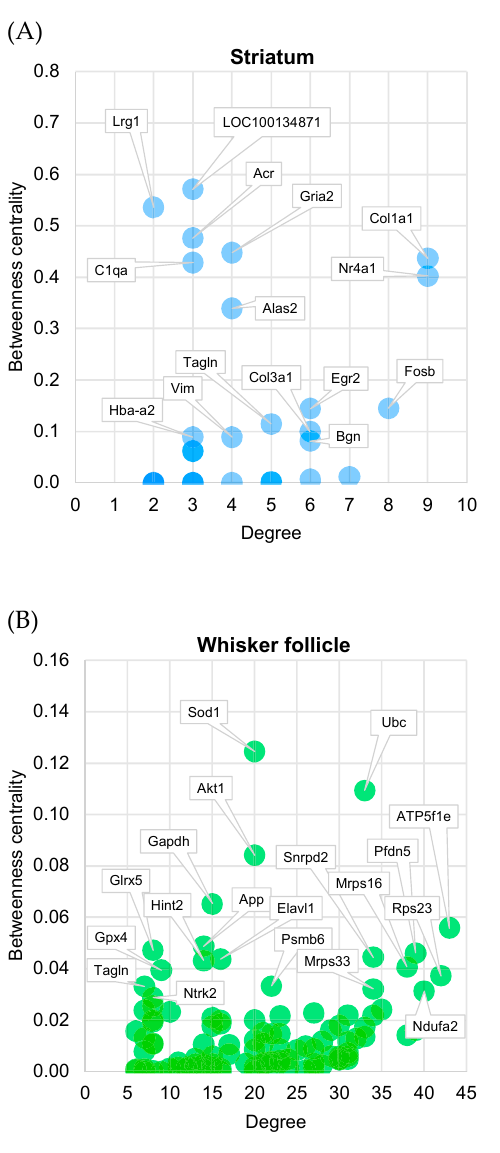
Figure 6. Centrality analysis and lists of the top 20 hub genes. ( A , B ) Betweenness centrality values and degrees of the entire PPI networks were obtained by means of the NetworkAnalyzer tool in the Cytoscape software (v3.7.1). Cut-offs of the degree for PPI networks in each tissue were set to 2 (striatum) and 5 (whisker follicle). Hub genes were arranged in the order of decreasing betweenness centrality values. A scatter plot of betweenness centrality versus the degree for nodes from PPI networks (left panel). The top 20 hub genes of PPI networks are listed in the lower panel. FC, fold change; BC, betweenness centrality.